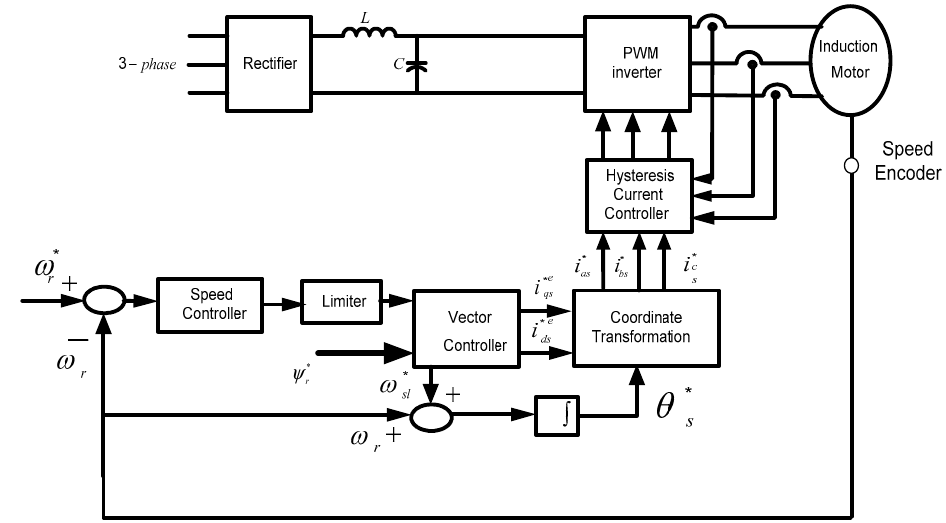
Figure 1. Block diagram of an indirect field-oriented (IFO)-controlled induction motor drive.